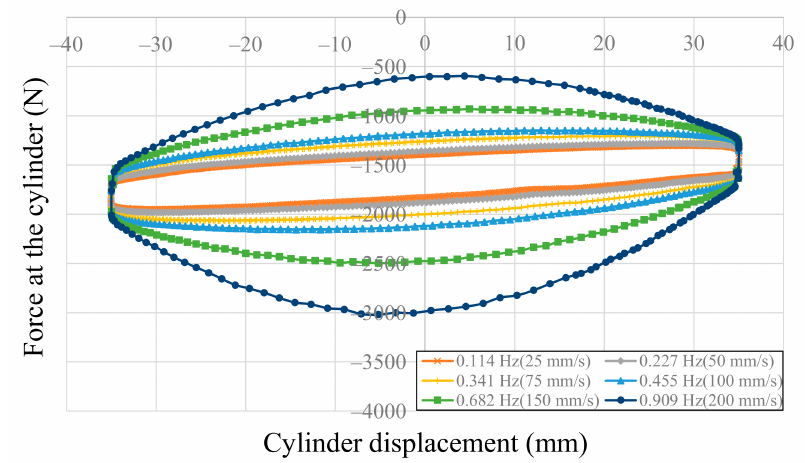
Figure 10. Force-velocity results from test when applied valve current was 1080 mA (command 60%).